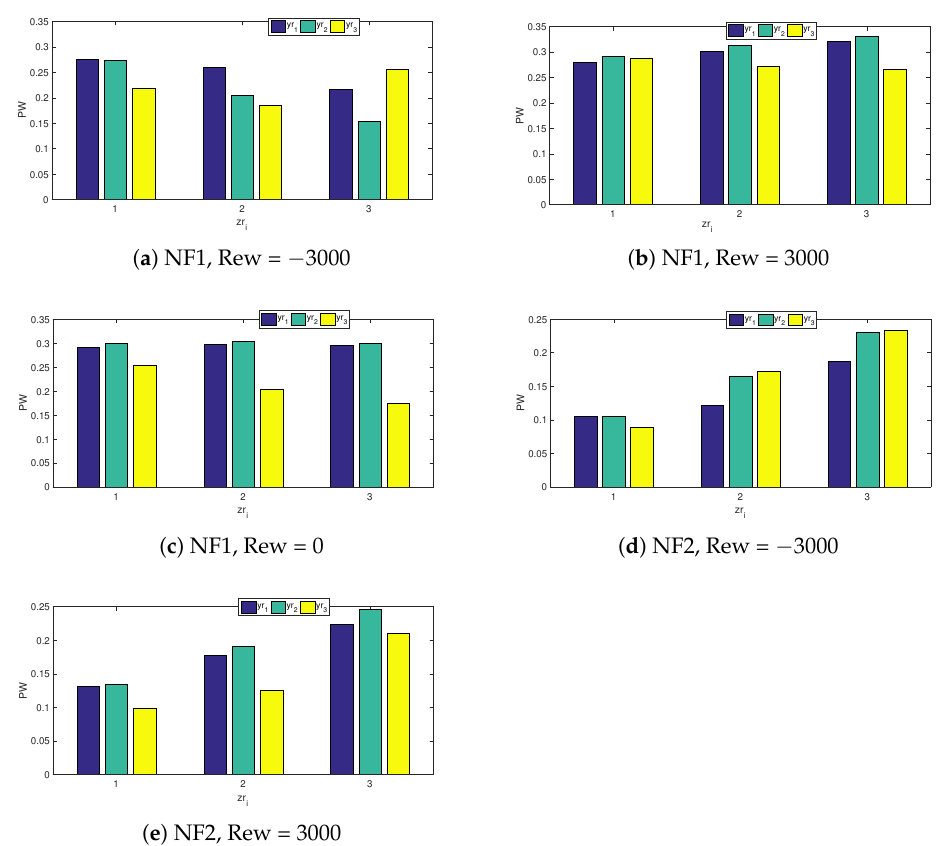
Figure 9. Effects of the rotating cylinder location on the variation of generated power for NF1 ( a – c ) and for NF2 ( d , e ) for various Rew values (R = 0.18